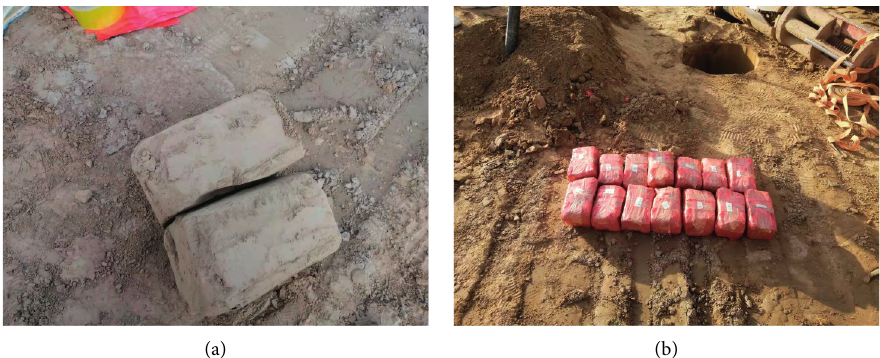
Figure 2: Photos of intact loess sampling. (a) Intact soil photos. (b) After intact loess sampling.